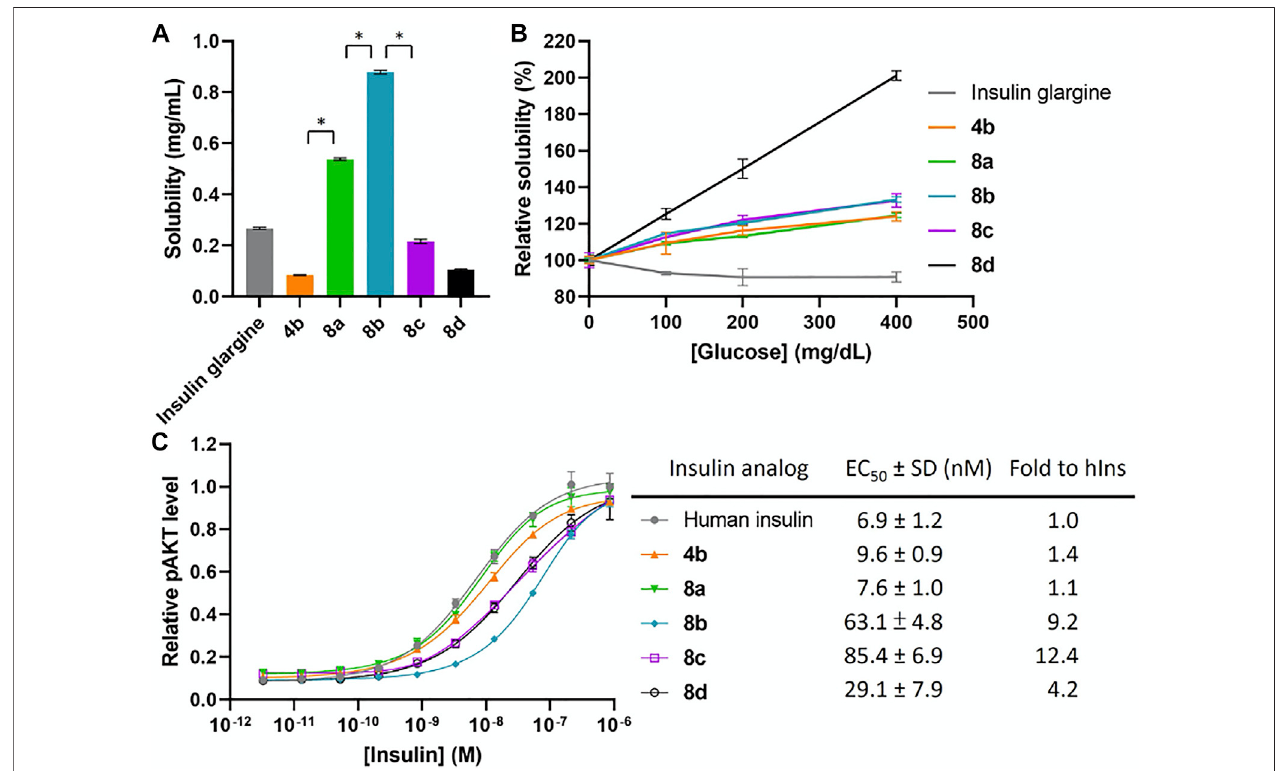
FIGURE 3 | (A) Solubility of insulin analogs in pH 7.4 PBS. Data are expressed as mean ± SD ( n = 4 per group). The statistical comparison of the two groups was evaluatedbytheunpairedtwo-tailedStudent ’ st-test.* p < 0.001. (B) SolubilityofinsulinanalogsinpH7.4PBSwithdifferentglucoseconcentrations.Dataareexpressed as mean ± SD ( n = 4 per group). (C) In vitro activity of insulin analogs by using activated pAKT levels as measurements. Data are expressed as mean ± SD ( n = 4 per group). EC 50 was calculated by Prism 9 (GraphPad Software, CA, United States) with nonlinear regression curve fi tting of dose-response asymmetric equation.